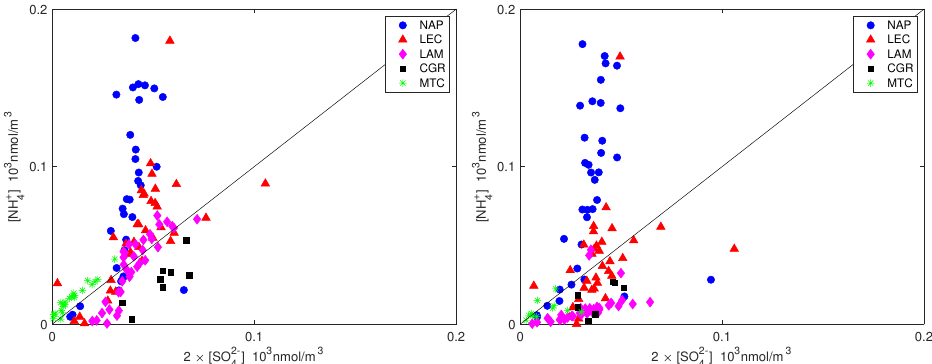
0 0.1 Figure 8. Ammonium plotted against the equivalent sulfate concentration for PM 10 ( left ) and PM 2.5 ( right ). The straight line is the 1:1